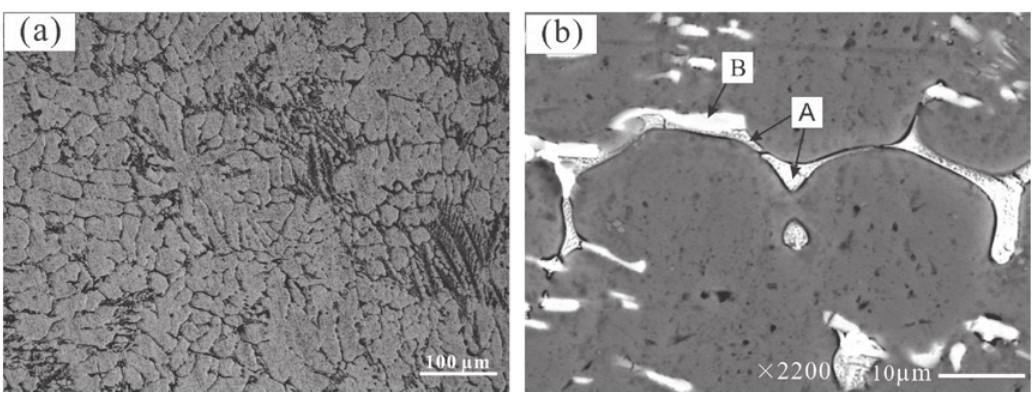
Fig. 1: Microstructure of as-cast alloy 2618 prepared by conventional DC